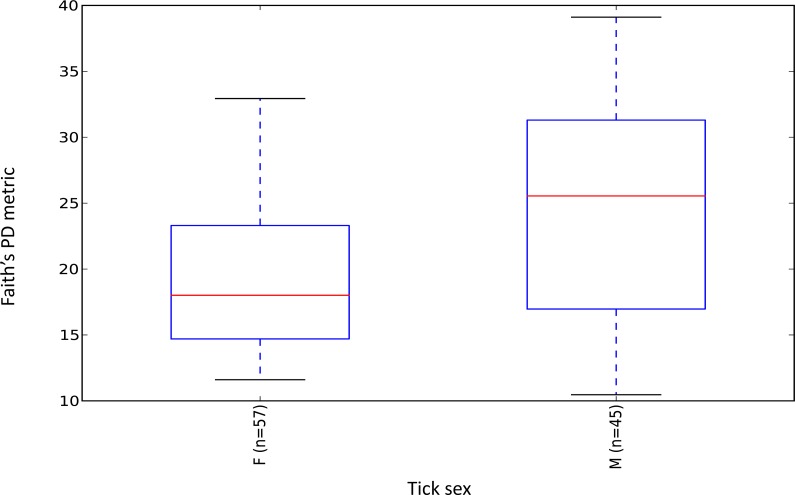
Boxplot of microbiome alpha diversity in D. occidentalis ticks measured by Faith’s phylogenetic diversity (PD) whole tree as implemented in QIIME of male and female D. occidentalis.Faith’s PD, two sample t-test, male versus female; t = 3.63, P < 0.01.